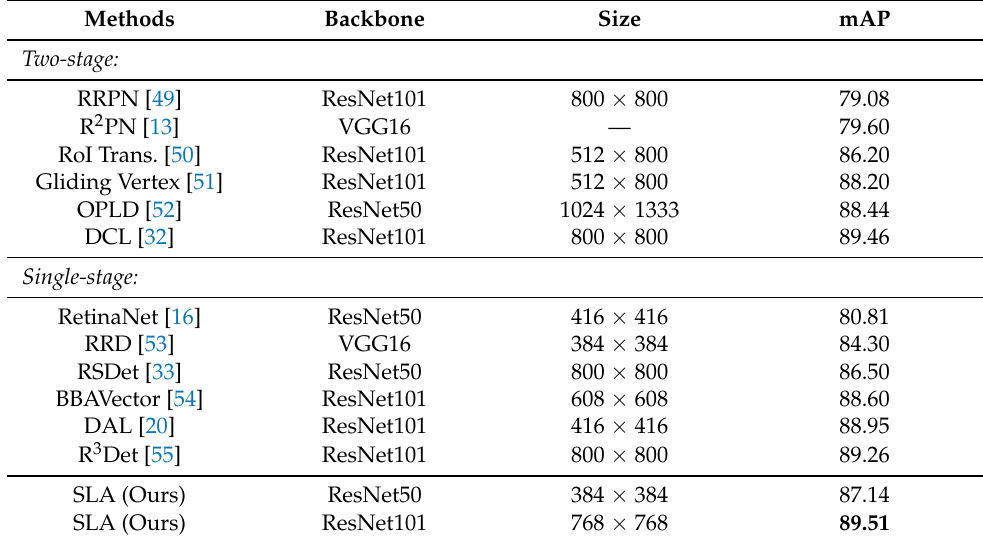
Table 5. Comparisons with other methods on HRSC2016 dataset.